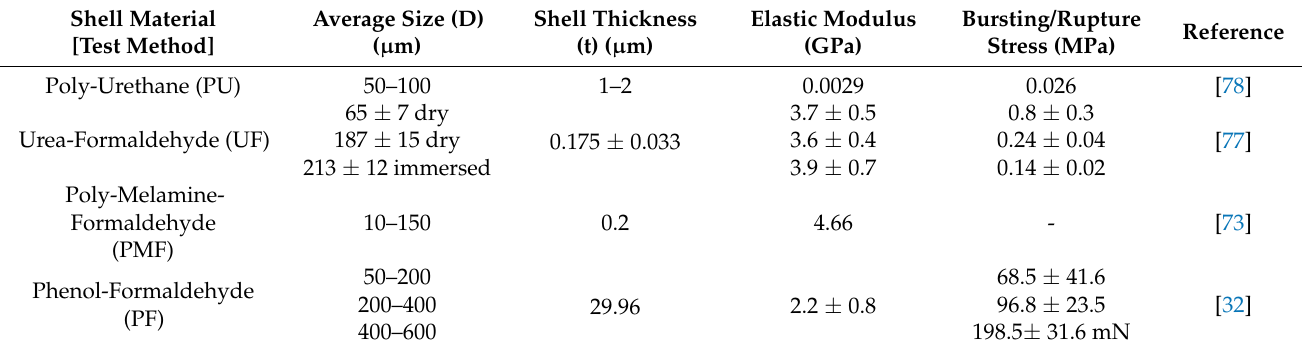
Table 2. Properties of capsules extracted from the